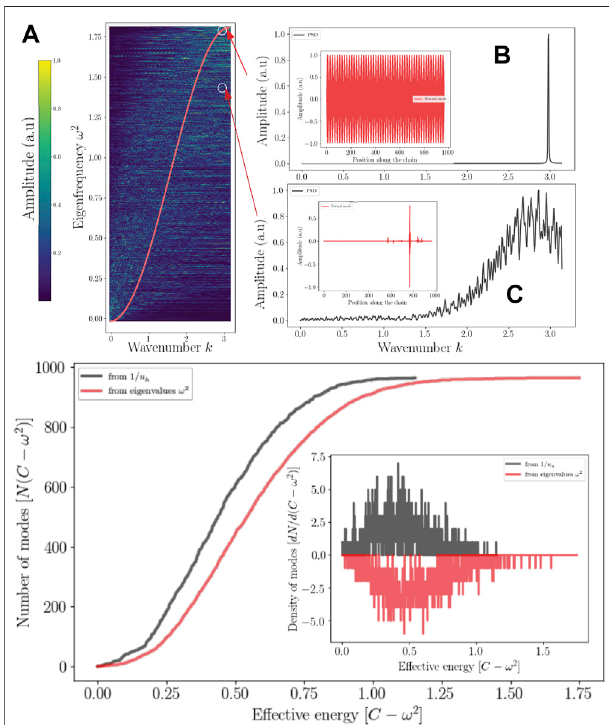
FIGURE 5 | Localization and reciprocal space Top: Localized wave and the reciprocal spaces (A) Dispersion relation of (S) compared to a perfect chain of the same size (red) (A) . The range of the power spectral density of a localized mode is enlarged (C) compared (B) to a delocalized mode (standing wave). Bottom: The eigenvalues counting function predicted by the effective potential (dark) as well as that obtaiFed from the eigenvalues of Λ . Their derivative correspond to the DOS